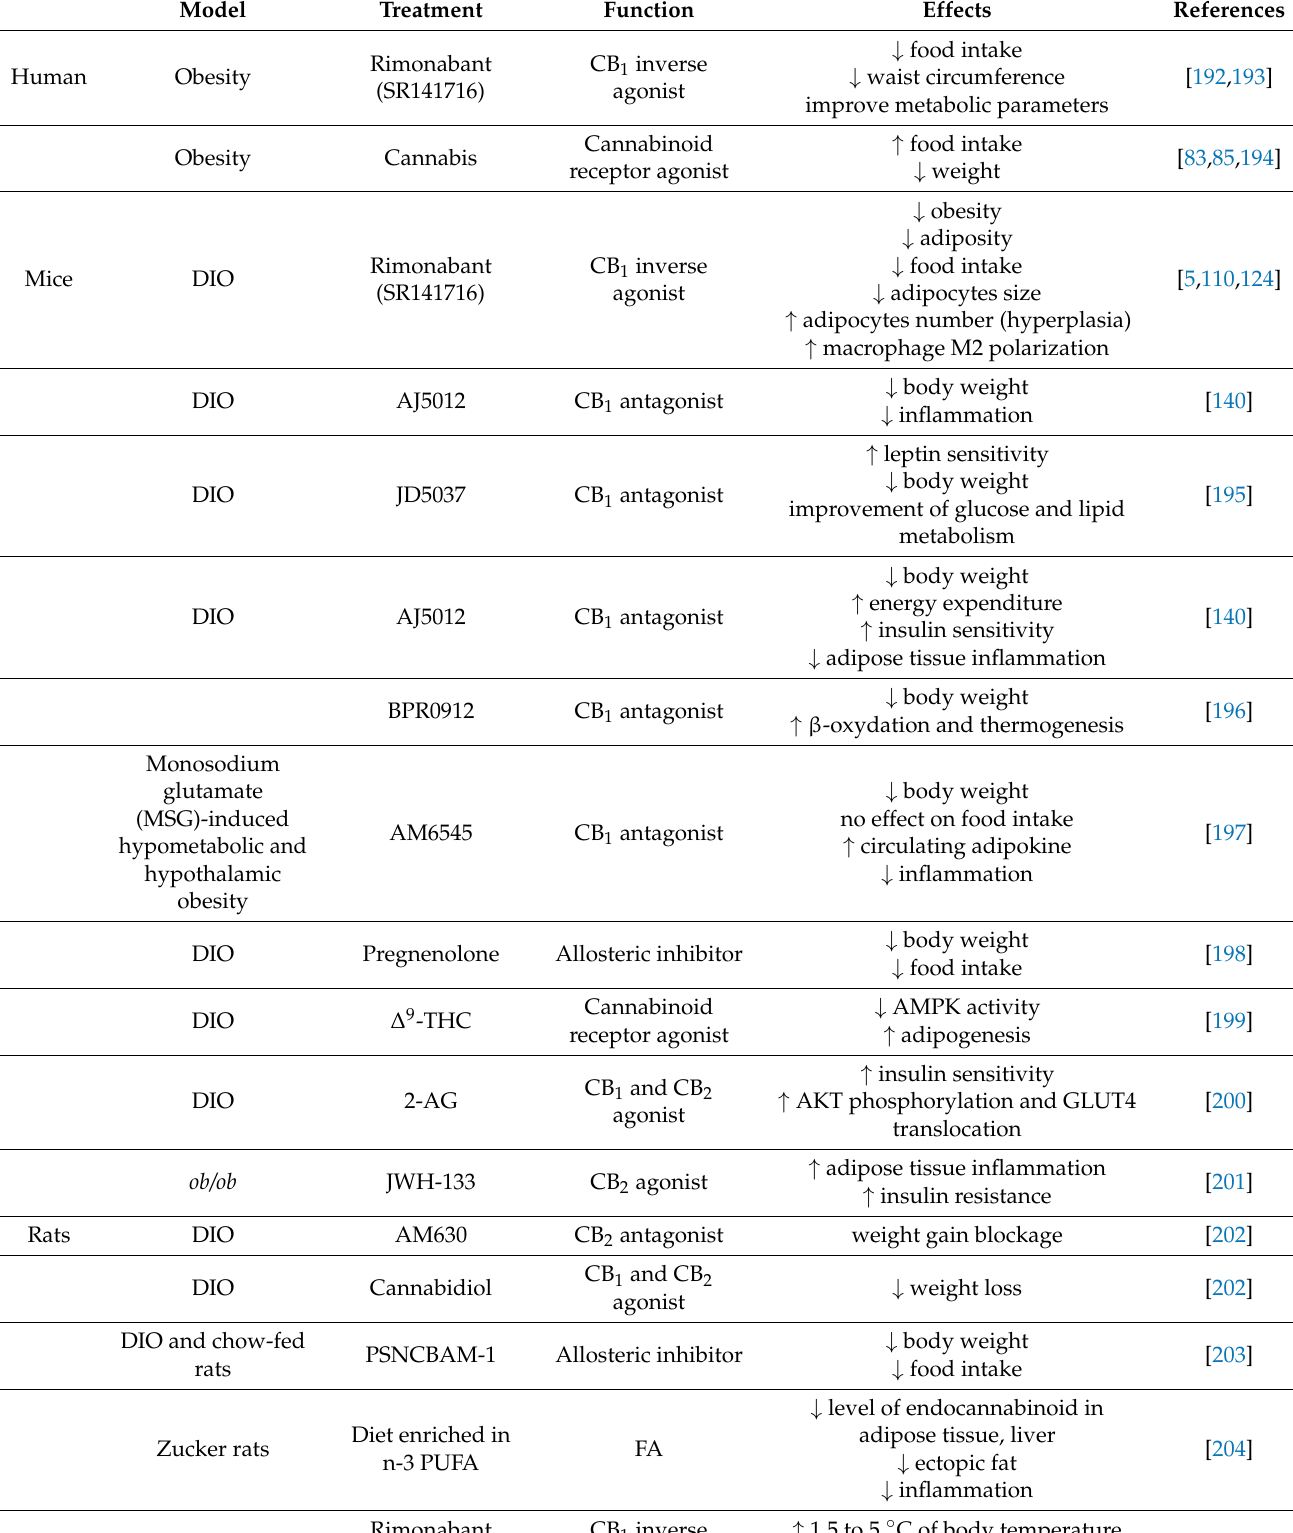
Table 4. Effect of treatments targeting more or less selectively the eCB system. Several treatments are being developed, which can influence metabolism or the inflammatory response, to treat obesity and associated metabolic diseases. DIO, diet-induced obesity; FA, fatty acid; PUFA, poly-unsaturated fatty